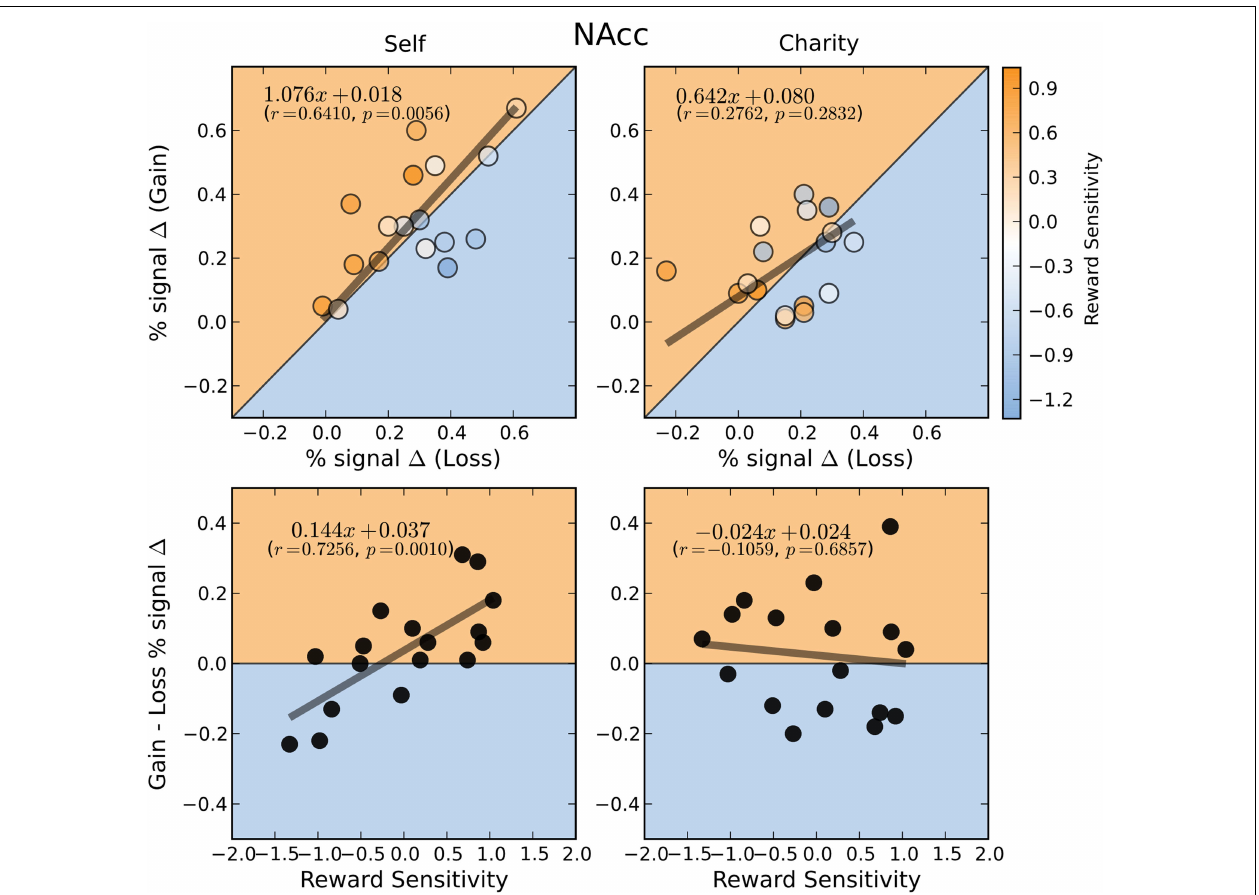
FIGURE 5 | BOLD responses in the NAcc during gain and loss anticipation are positively correlated when participants play for themselves. Top : Average percent signal change differences (paid-control) for anticipation of gain and loss trials for the Self (left) and Charity (right) treatments. Each point is colored according to the participant’s relative reward sensitivity index